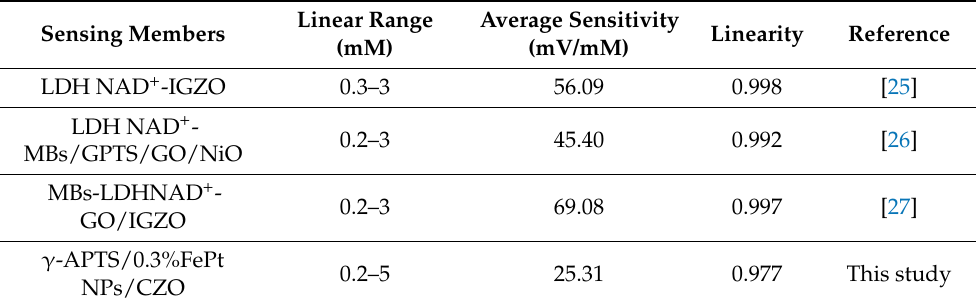
Table 4. Comparisons of linear range, average sensitivities, and linearity of potentiometric lactate biosensors with various sensing